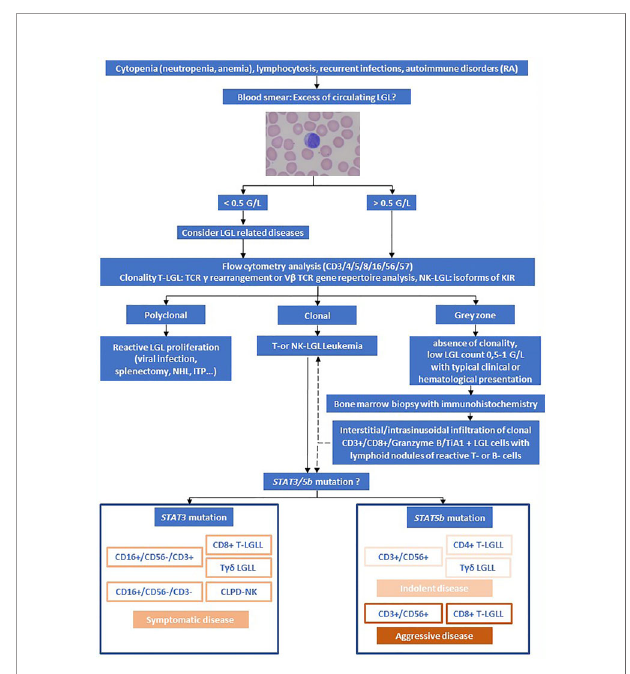
FIGURE 1 | Algorithm for the evaluation of LGL Leukemia. Adapted from Lamy et al. and Teramo et al. (1, 11). Rheumatoid arthritis (RA), Non-Hodgkin Lymphoma (NHL), immune thrombocytopenia